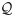
Example of a trajectory planning environment.The agent is initially in r0 in a trajectory planning problem, and in this case, x0 = [1 0 6 0]T and Q could be defined by 8 m ≤ rx ≤ 10 m, 1 m ≤ ry ≤ 3 m, |vx|≤0.01 m/s and |vy|≤0.01 m/s, for example.